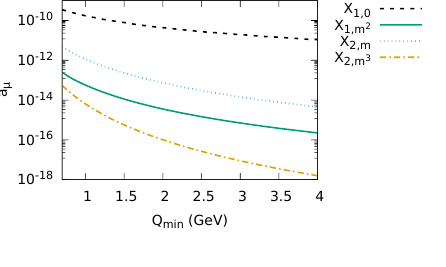
Figure 4. Contributions from X 1 , 0 , X 6 , X 7 , X 8 , 1 and , X 2 , m and 1 , m 2